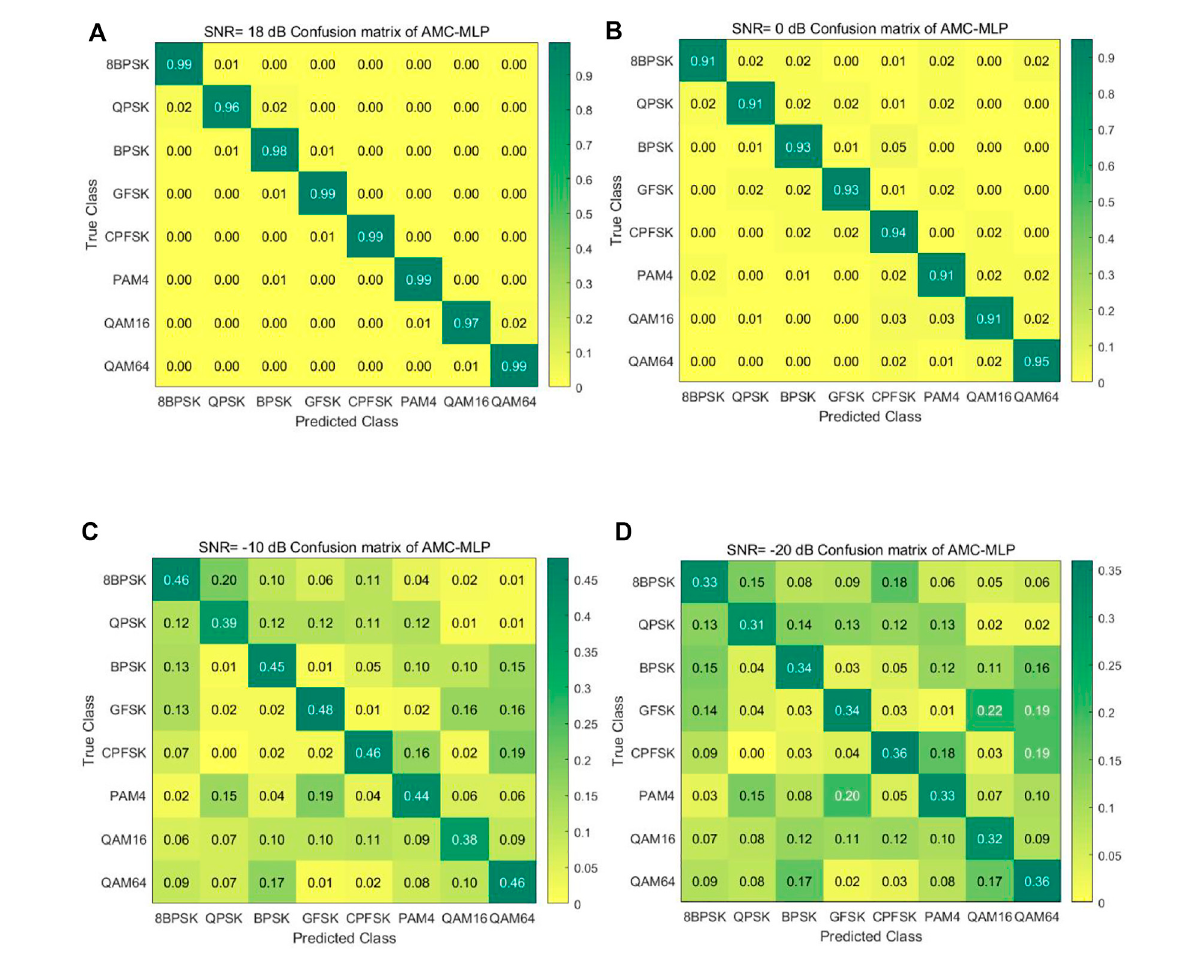
FIGURE 6 Accuracy confusion matrix of AMC-MLP algorithm with different SNR. (A) SNR = 18 dB, (B) SNR = 0 dB, (C) SNR = − 10 dB, (D) SNR = − 20